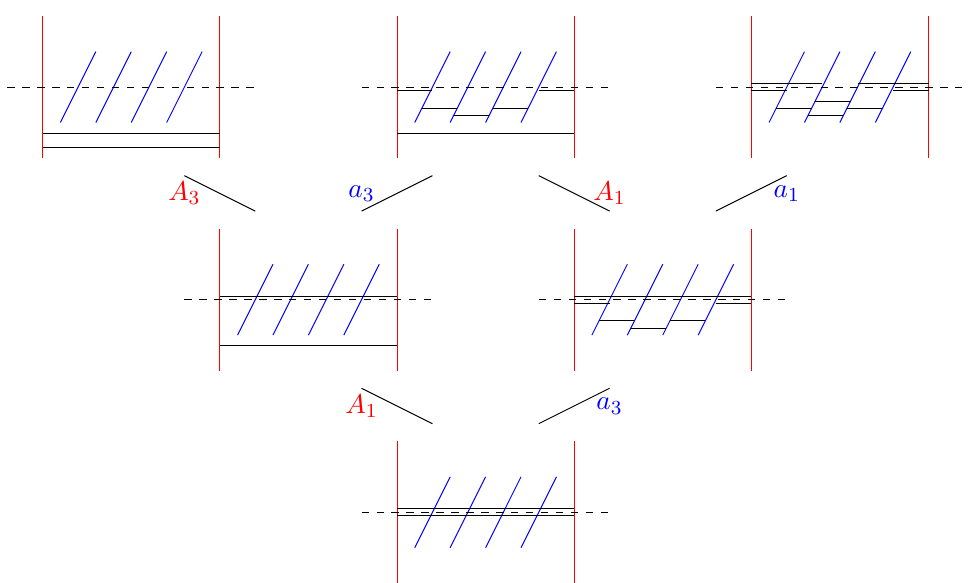
Figure 5 . Brane configurations corresponding to the leaves in (3.6). See appendix B for more